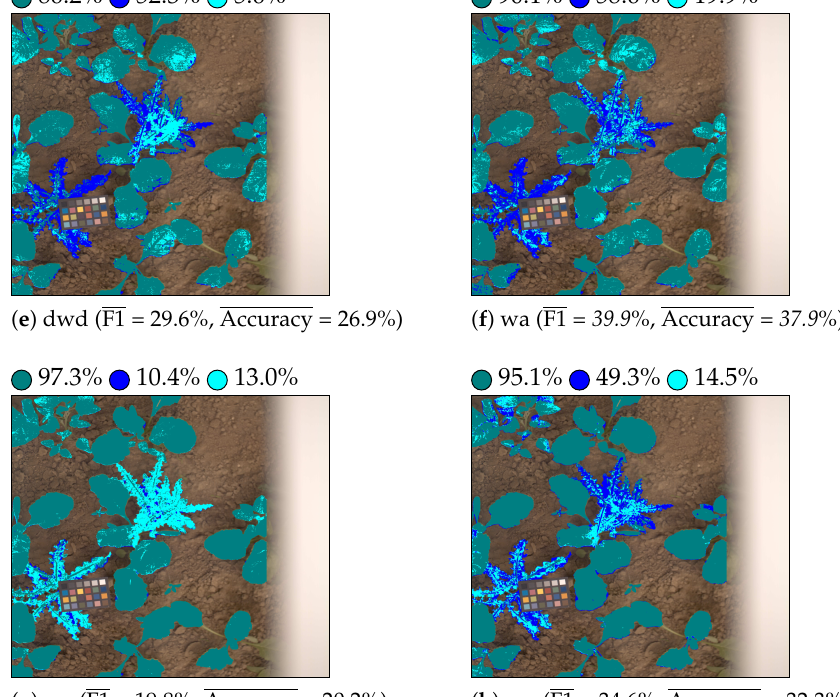
Figure 7. Beet/thistle/goosefoot identification. Beet is displayed as teal, thistle as blue, and goosefoot as cyan. The per-class accuracy score is displayed near each colored circle (class label) for each considered